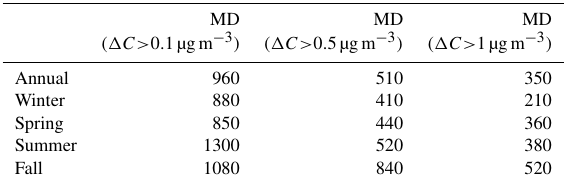
Table 1. MD for annual and seasonal impacts of shipping emissions in kilometers